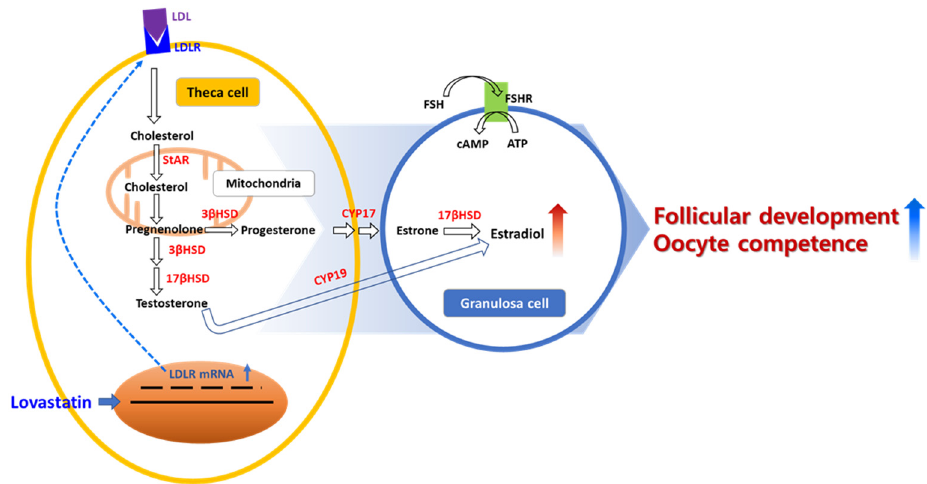
Figure 5. Scheme of LDLR activity signaling pathway for follicular development with lovastatin stimulates steroidogenesis in ovaries.